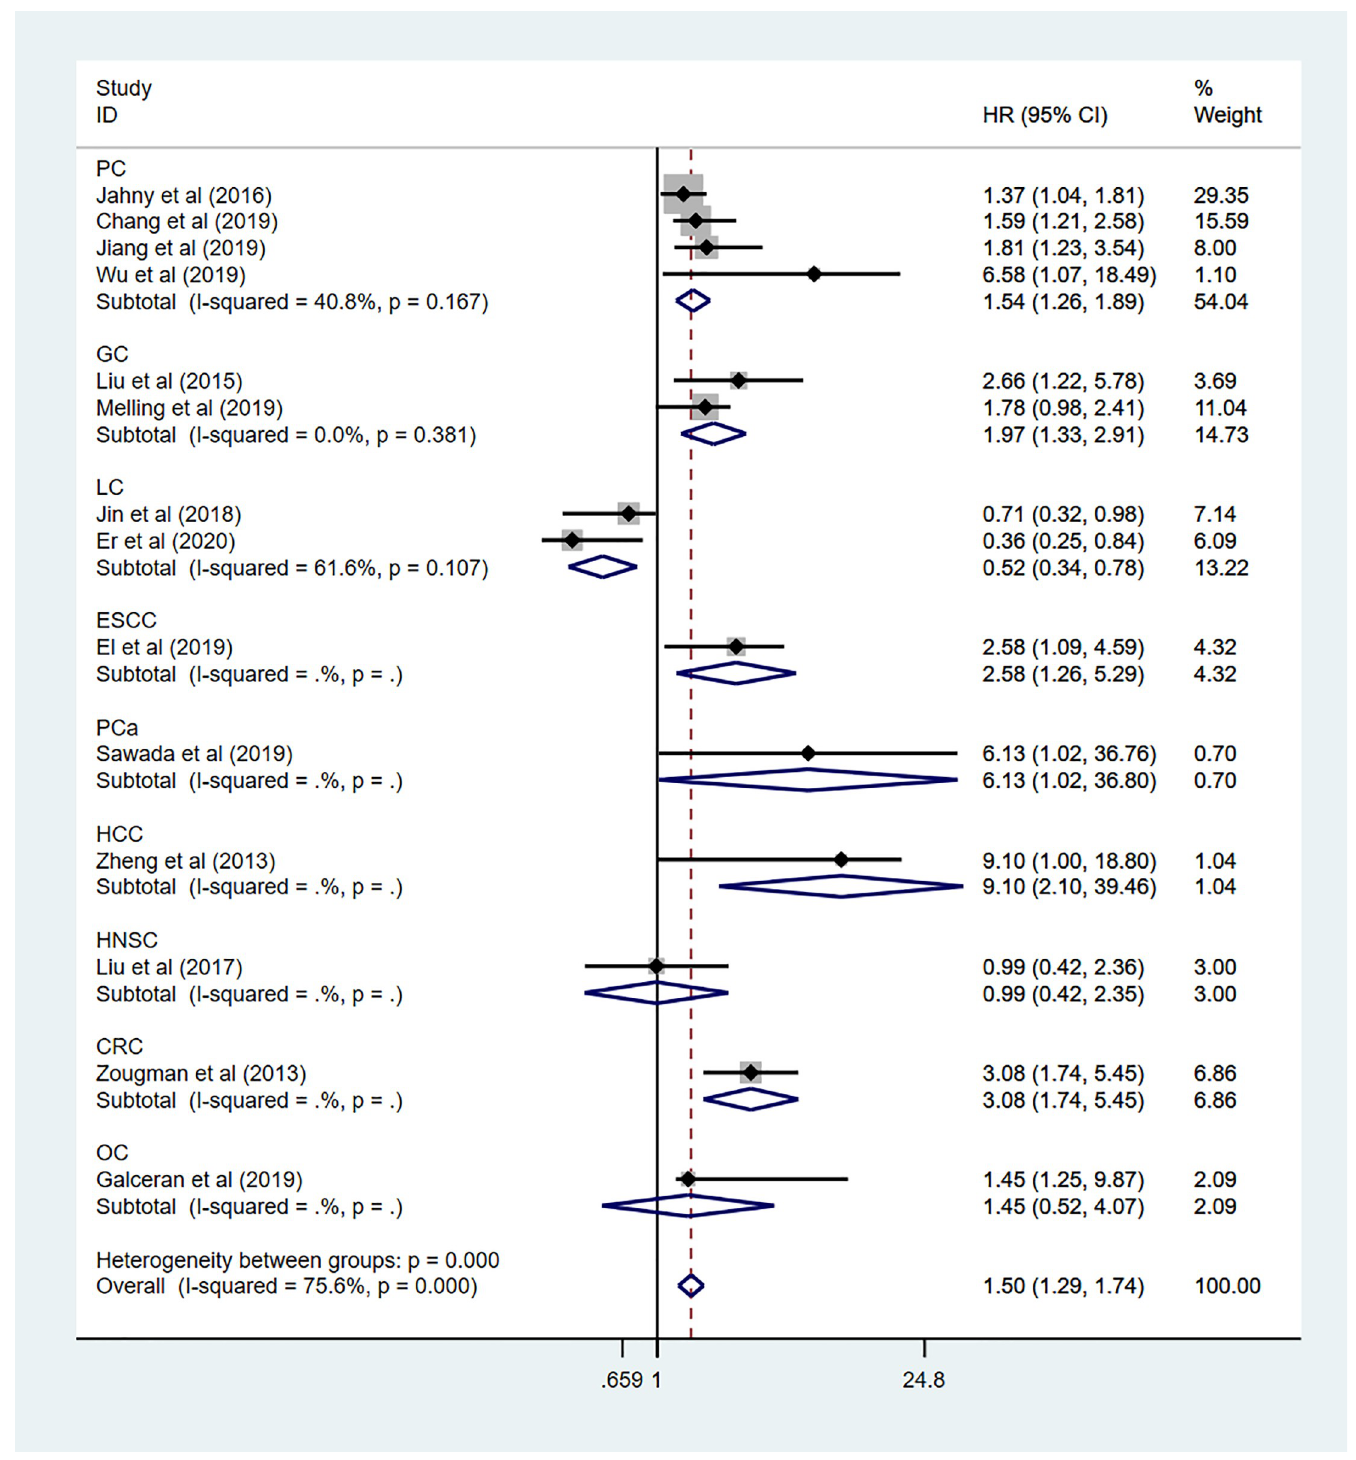
Fig 5. Forest plot of Overall analysis of GPRC5A expression in multiple carcinoma.